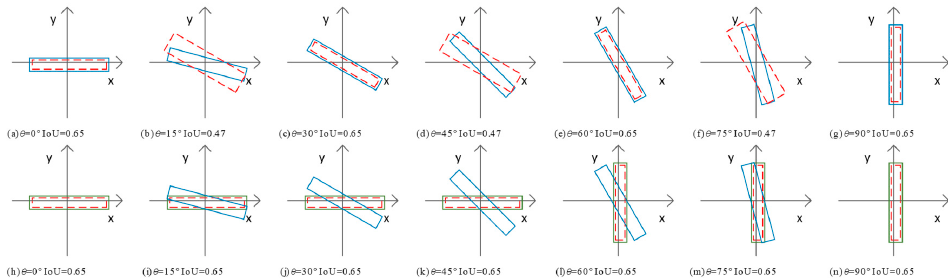
Figure 3. Rotation-decoupled matching strategy versus the strategy based on oriented anchors. The red bounding box indicates the matched anchor.